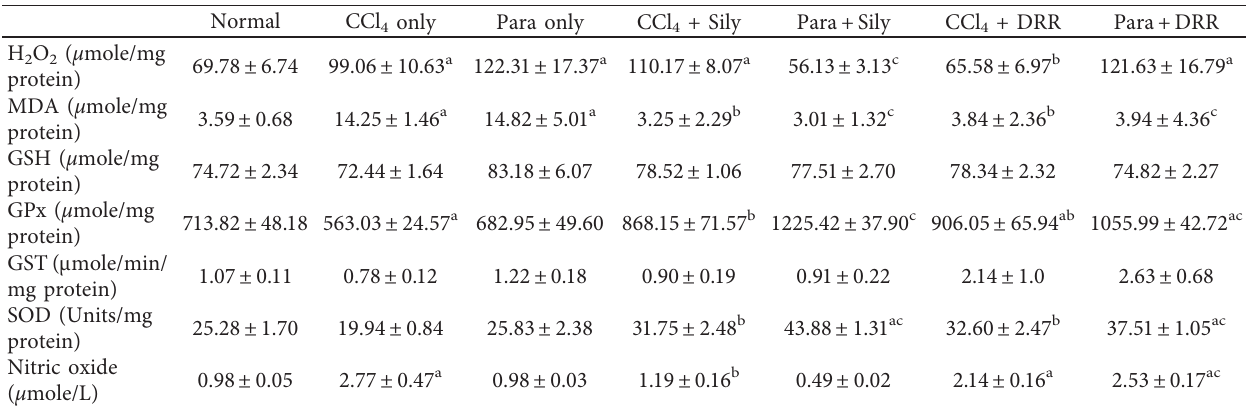
Figure 2: Percentage protection of silymarin and the extracts of D. erecta against CCl Table 3: Effect of treatment on liver oxidative stress